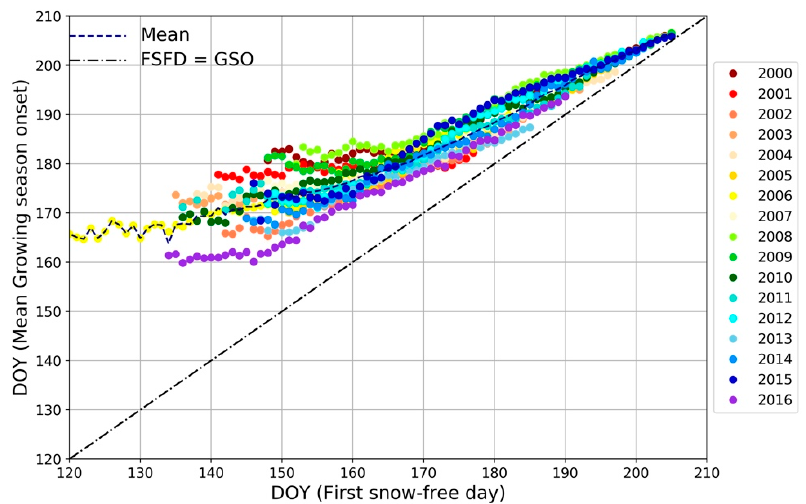
Figure 11. Scatterplot showing the relationship between first snow-free day and the average growing season onset (GSO) date. The mean growing season date for all years is indicated by the dashed line and the dashed-dot line indicates where first snow-free day would be equal to growing season onset.